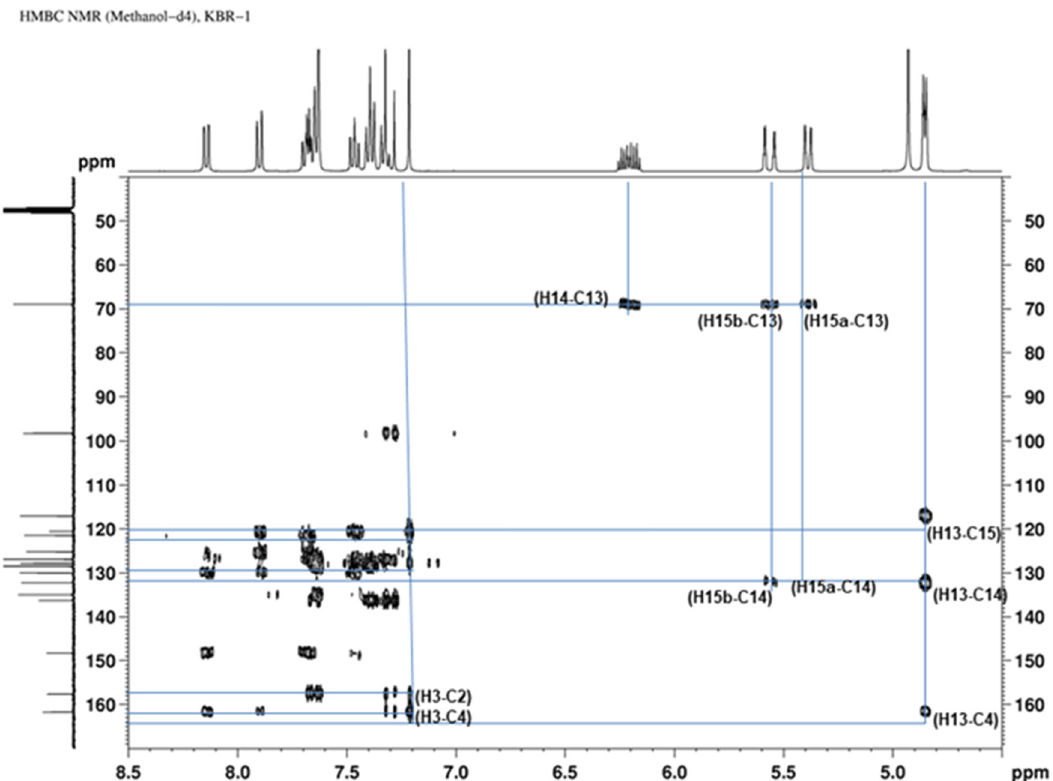
Figure 9: 1 H – 1 H HMBC spectrum of compound 2h in methanol - d 4